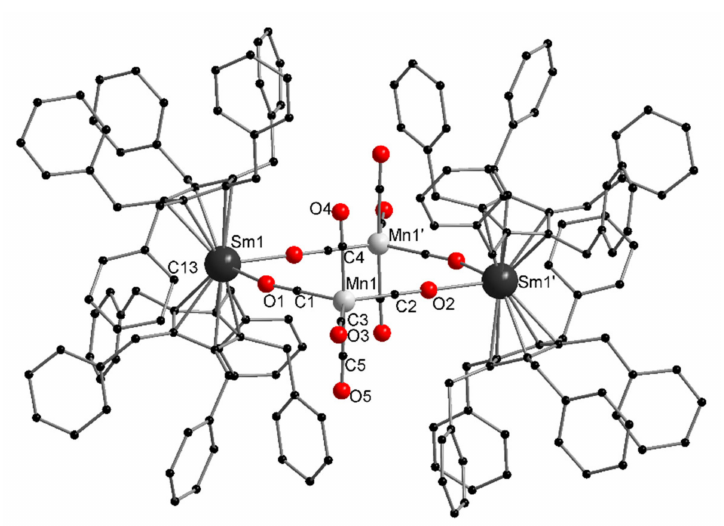
Figure 3. Molecular structure of 4 in the solid state. Hydrogen atoms and solvent molecules are omitted for clarity. Selected bond lengths [Å] and angles [ ◦ ]: Sm1-O1 2.409(5), Sm1-O2‘